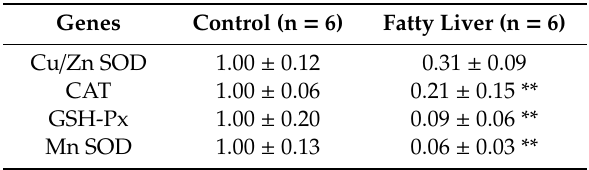
Table 5. Genes mRNA abundance for antioxidation activity of control and fatty liver cows (means ±